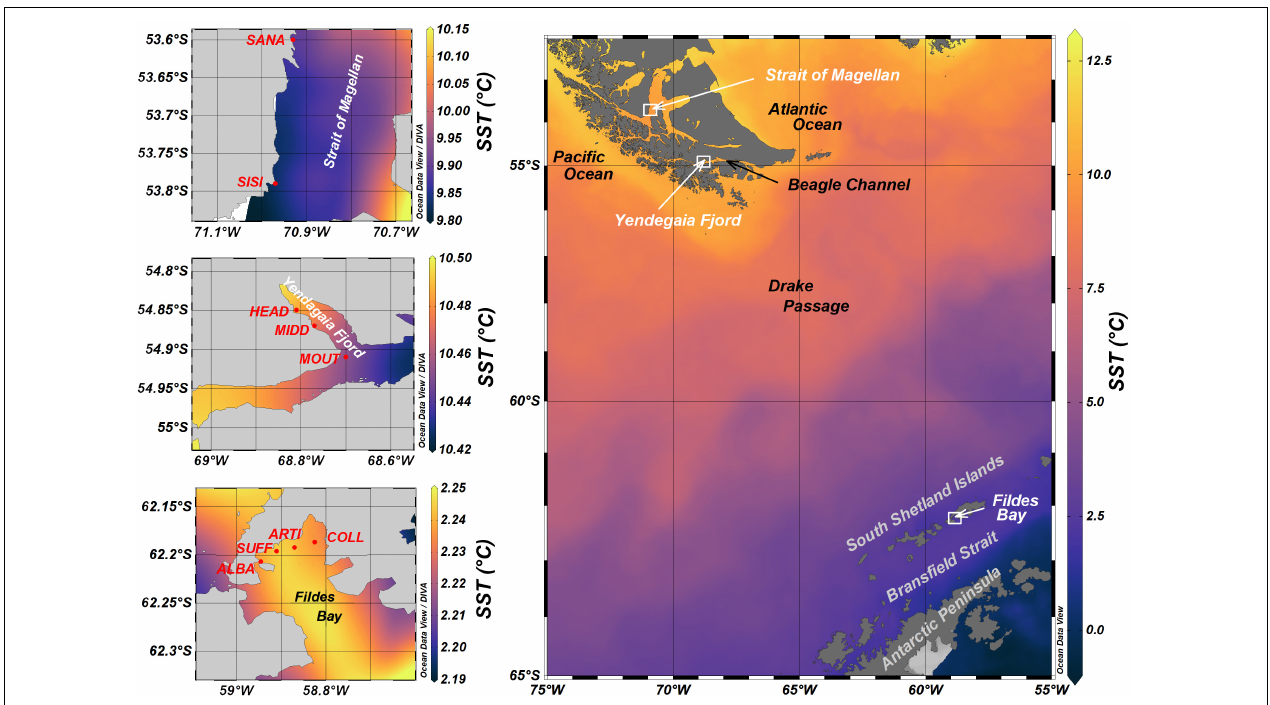
FIGURE 1 | Geographic positions of localities and sites. Strait of Magellan (STRA) and Yendegaia Fjord (YEND) are located in Chilean south Patagonia; Fildes Bay (FILD) is located in West Antarctic Peninsula. See all region and site codes in Table 1 . Colour scales depict maximal sea surface temperatures (monthly averages) obtained between 2010 and 2020. Data were derived from a multi-sensor ultra-high-resolution analysis (https://coastwatch.pfeg.noaa.gov/erddap) and visualised in Ocean Data View (Schlitzer, 2018; http://odv.awi.de).